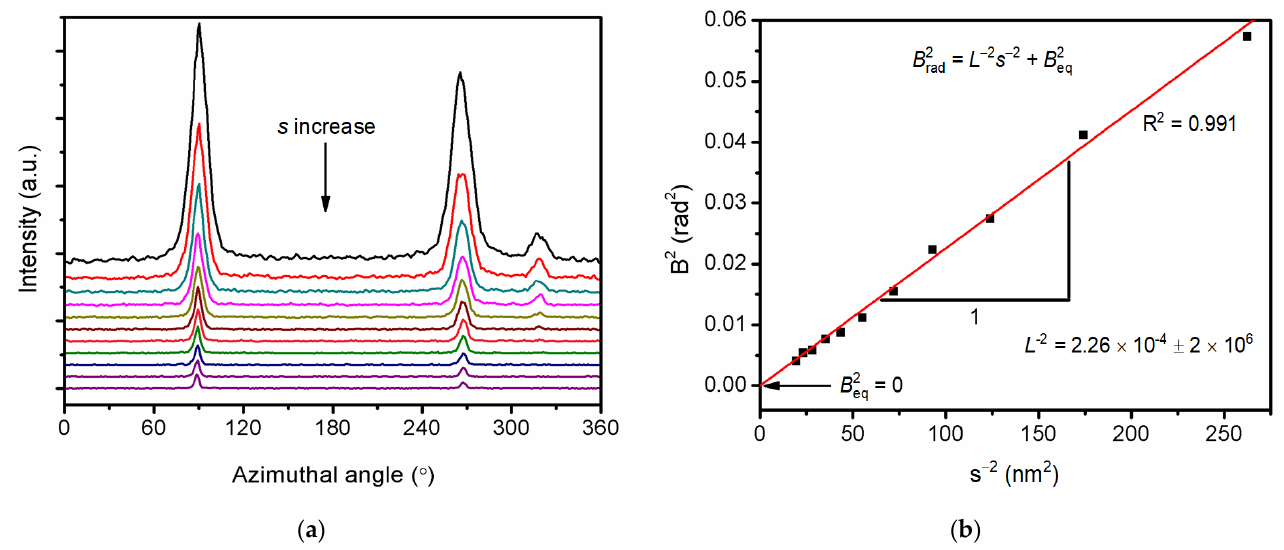
Figure 5. SAXS data analyzing by the Ruland method: ( a ) Azimuth integral of SAXS data, ( b ) Ruland fitting result.